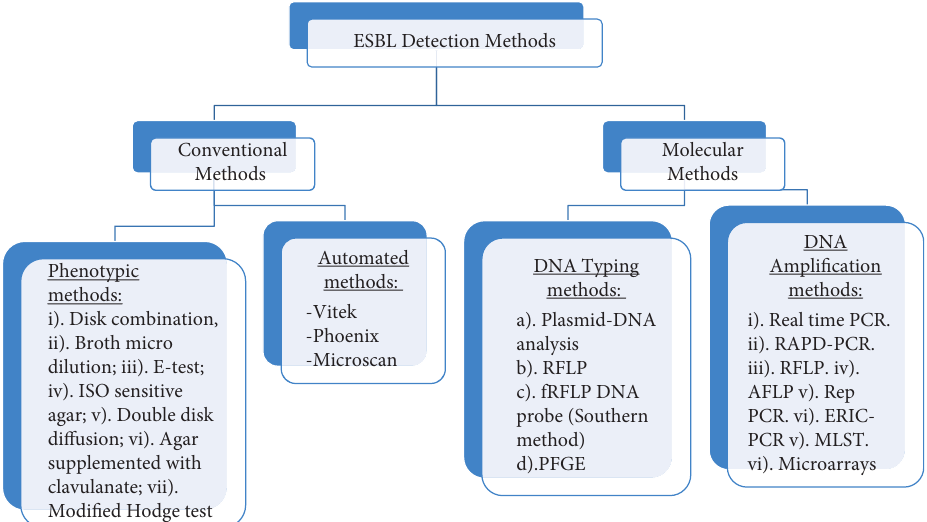
Figure 1: Simple flow chart of extended spectrum beta-lactamase enzyme detection in any microbiology laboratory. ESBL � extended spectrum beta-lactamase; DNA � deoxyribonucleic acid; RFLP � restriction fragment length polymorphism; fRFLP; PFGE � pulsed field gel electrophoresis; PCR � polymerase chain reaction; RAPD-PCR � random amplification of polymorphic-PCR; RFLP-PCR � restriction fragment length polymorphism-PCR; AFLP � amplified fragment length polymorphism; Rep-PCR � repetitive extragenic palindromic- PCR; ERIC-PCR � enterobacterial repetitive intergenic consensus-PCR; MLST � multilocus sequence